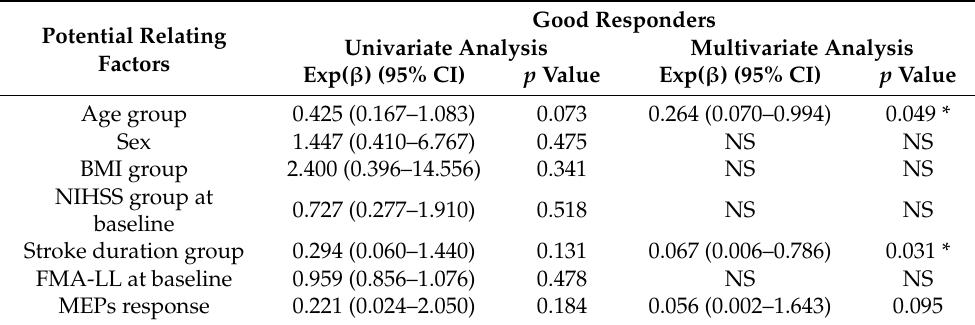
Table 2. Univariate logistic regression analysis of the association between baseline clinical features with responders in lower limb score of Fugl–Meyer assessment of patients treated with stem